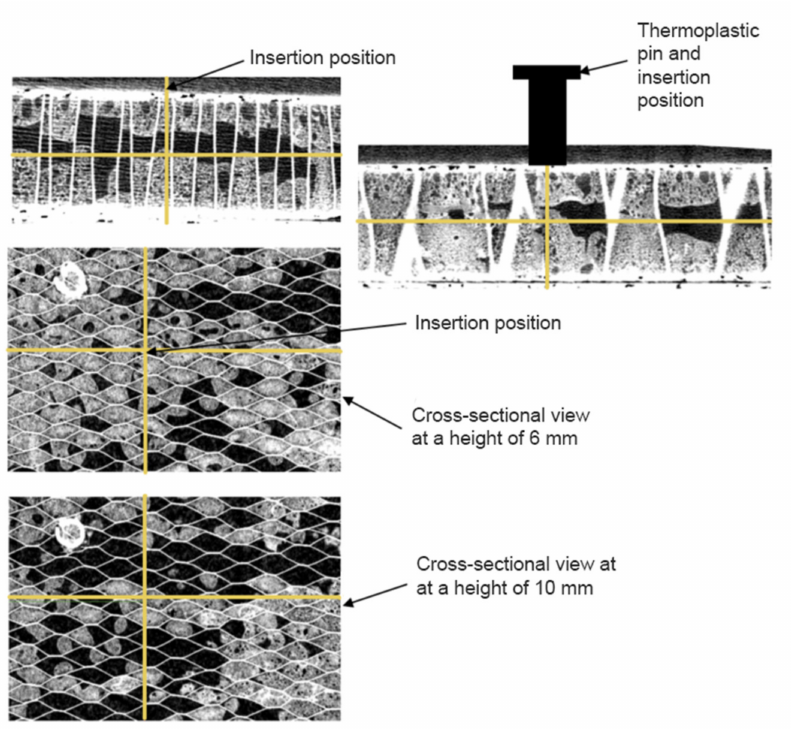
Figure 5. Computer tomography (CT) scanned sandwich structure with corresponding insertion position highlighted with yellow coordinate